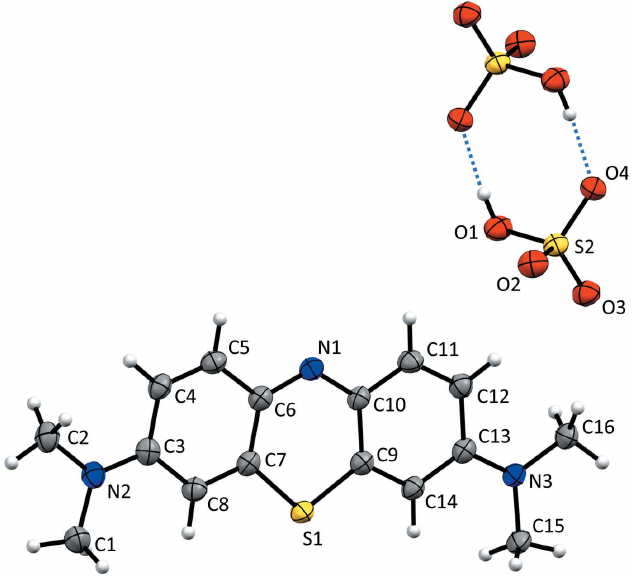
Figure 2 The molecular structure of compound ( II ), with the atom labelling. Displacement ellipsoids are drawn at the 50% probability level. Hydrogen bonds are shown as dashed lines (see Table